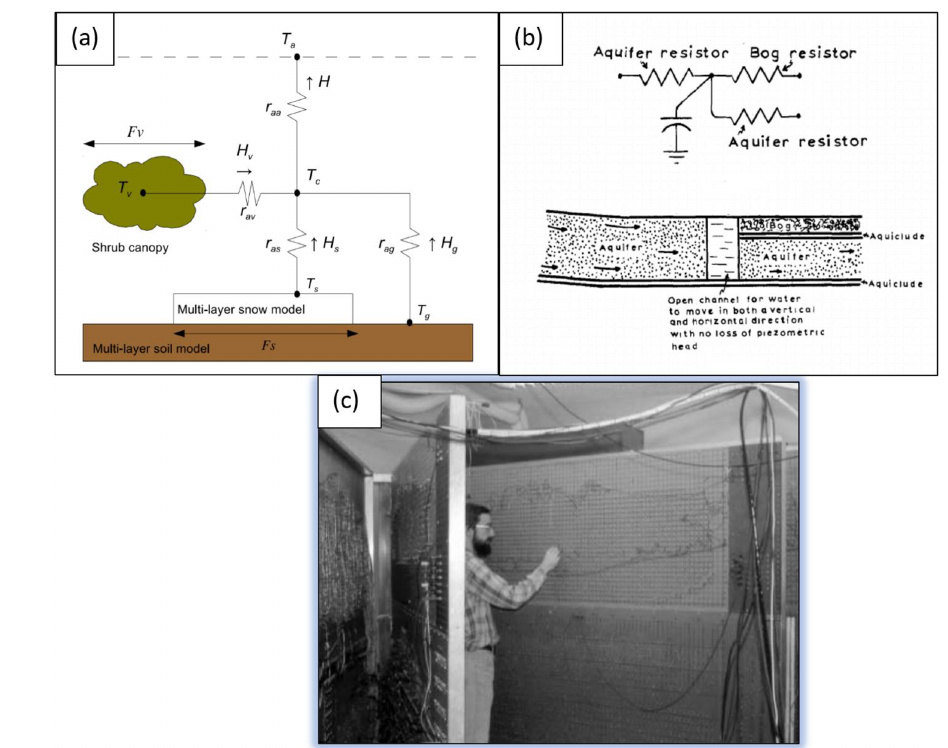
Figure 5. (a) Example of an analogue model used for modelling heat exchange between snow, soil, a shrub canopy, and the atmosphere at a sub-Arctic tundra site (Ménard et al., 2014). For a complete explanation of terms, please see Ménard et al. (2014). Visible on this circuit schematic are resistors connected to form a circuit. (b) Analogue model used to represent the flow of water in a peat bog (Sander, 1976). Visible on this circuit schematic are resistors and capacitors. (c) Picture showing a large analogue circuit in the 1970s used to model